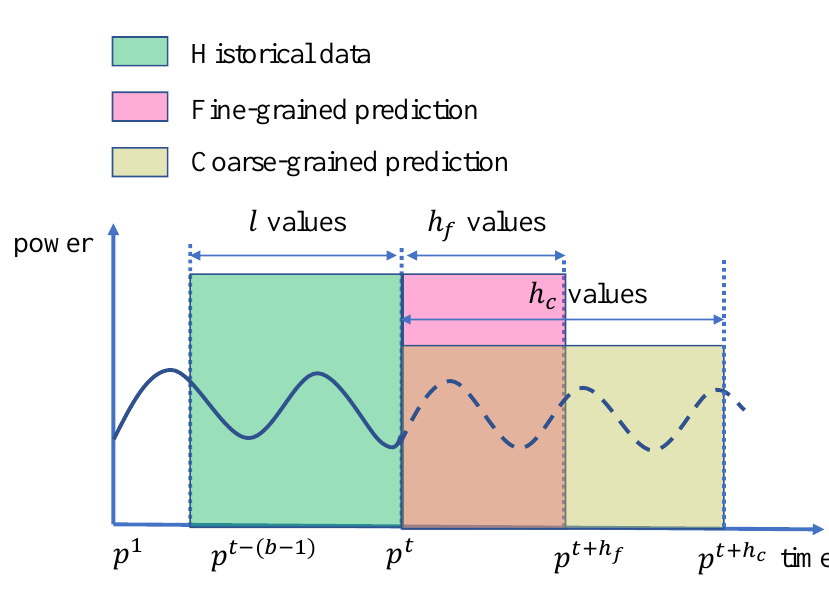
Figure 1. The power consumption prediction